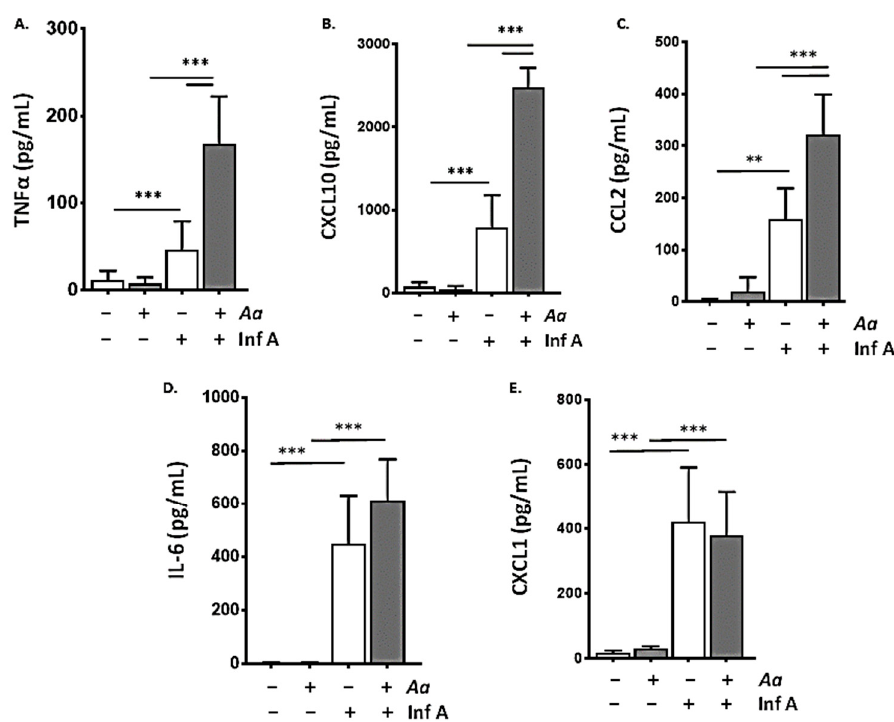
Figure 2. Repetitive administration of A. alternata amplifies the biochemical inflammatory response to infection with Inf A. Repetitive administration of A. alternata (5 µ g per inoculum) as in Figure 1A results in amplification of ( A ) TNF α , ( B ) CXCL10, and ( C ) CCL2 in BAL fluid (day 6 as per Figure 1A) compared to responses observed in response to a sublethal inoculum of Inf A infection alone. By contrast, repetitive administration of A. alternata had no impact on levels of ( D ) IL-6 or ( E ) CXCL1 (day 6 as per Figure 1A) compared to those generated in response to Inf A infection alone. For all cytokines evaluated (a–e), administration of A. alternata alone (i.e., no Inf A) resulted in no detection over background levels; n = 5–8 mice per point, ** p < 0.01, *** p < 0.005, 1-way